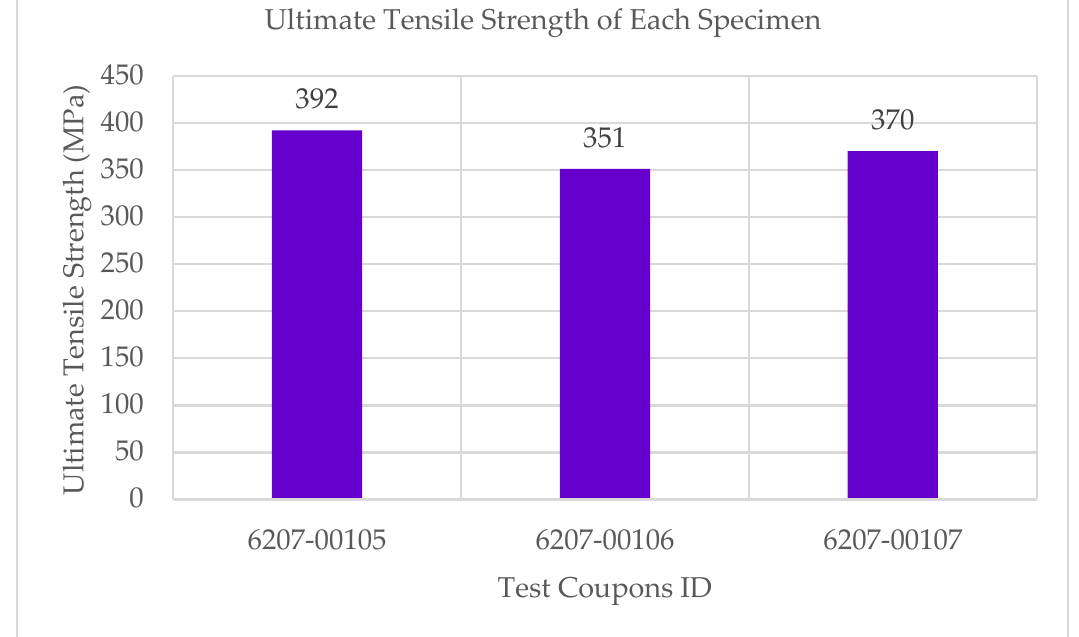
Figure 9. Ultimate tensile strength comparison of test coupons.